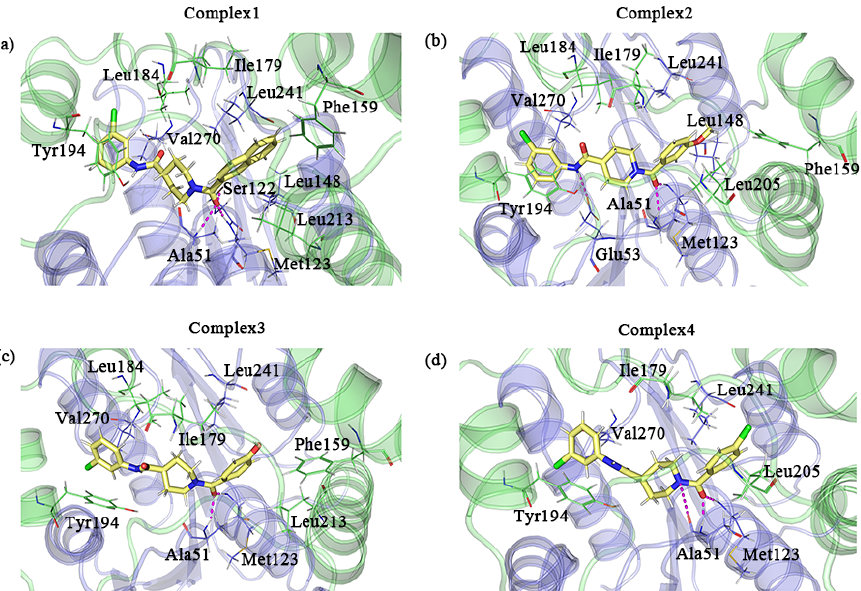
Figure 9. ( a – d ) A detailed diagram of the conformational observations for the complexes 1–4; the protein and residues of the lid domain are shown in green, and the rest of the protein and residues are shown in blue–purple. The key residues in complexes 1–4 that interact with the inhibitor are indicated by lines, where the inhibitor is indicated by the yellow stick mode. Hydrogen bonds are shown as pink dashed lines.